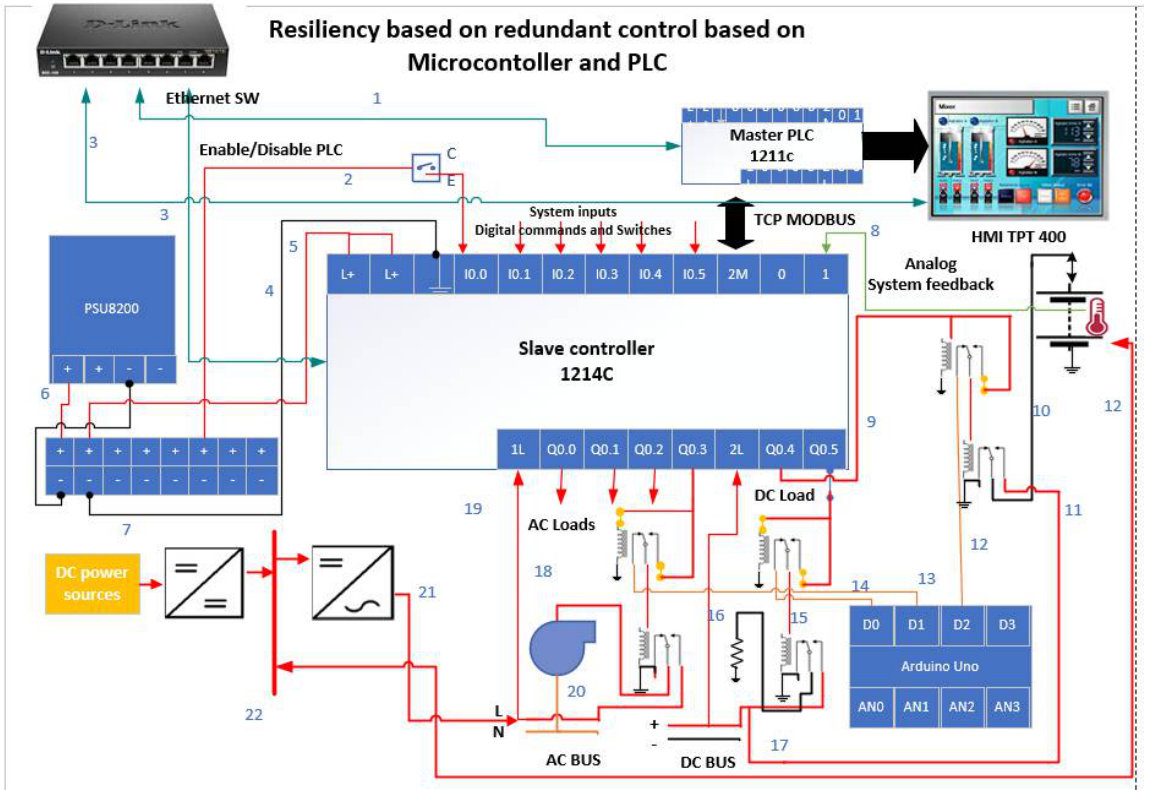
Figure 6. Microgrid